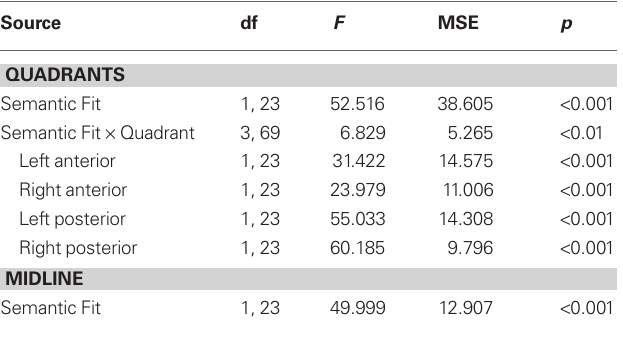
Table 2 | Analysis of variance for the mean ERP amplitudes in the 300–500 ms time window for the semantic manipulation.